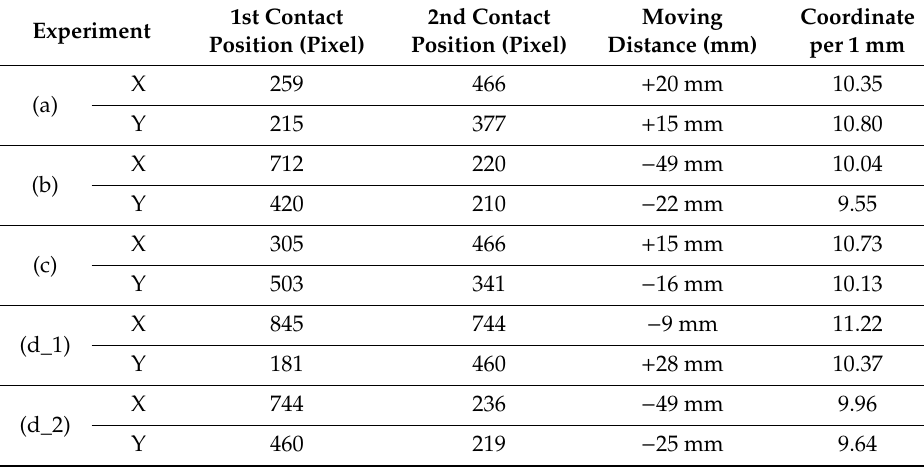
Table 4. Analysis of contact location along the travel